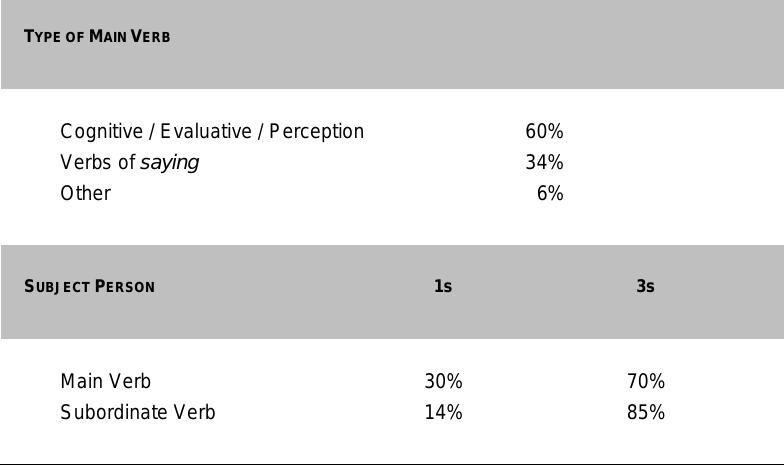
Table 4: Linguistic characteristics of verbs with intrusive que in subordinate arguments with object/patient